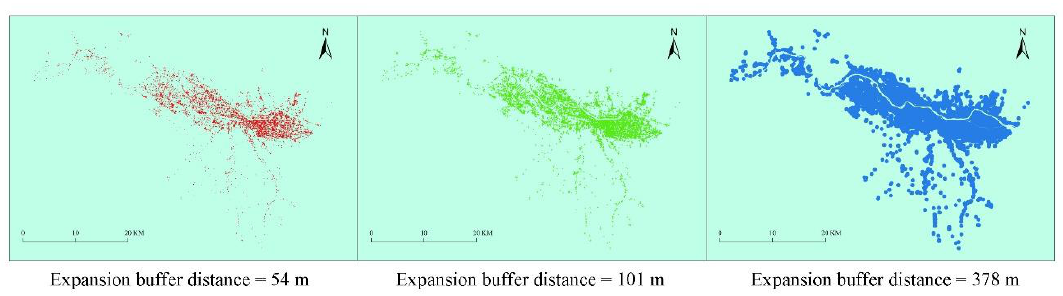
Figure 4. Schematic diagram of changes in the number of urban settlements.